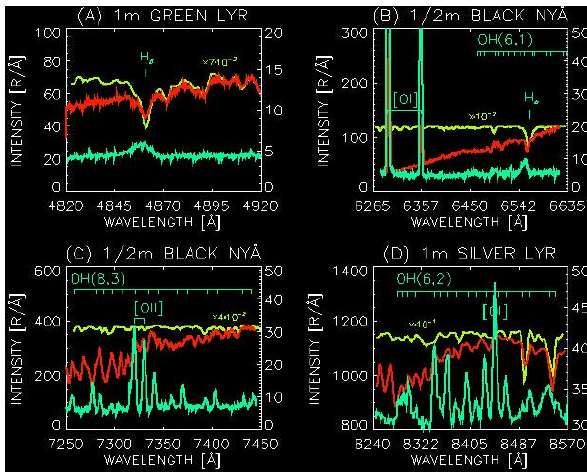
Fig. 3. Spectrometer data of the 6 December 2002 event from the Auroral Station in Adventdalen (Panel A and D) and from the sta- Figure 3. Spectrometer data of the Dec. 6, 2002 event from the Auroral Station in tion in Ny- ˚Alesund (Panel B and C). Green curves are prior to the Adventdalen (Panel A and D) and from the station in Ny-Ålesund (Panel B and C). event, indicating the normal dark sky conditions. Red spectra are Green curves are prior to the event, indicating the normal dark sky conditions. Red from the event itself. The yellow curves are a model spectrum of spectra are from the event itself. The yellow curves are a model spectrum of the sun. the sun. The intensities are in Rayleighs/ ˚Angstrøm [R/ ˚A] on both The intensities are in Rayleighs / Ångstrøm [R/Å] on both the left and right hand y- the left and right hand y-axis. The right hand axis represents normal axis. The right hand axis represents normal conditions (green curve). conditions (green curve).